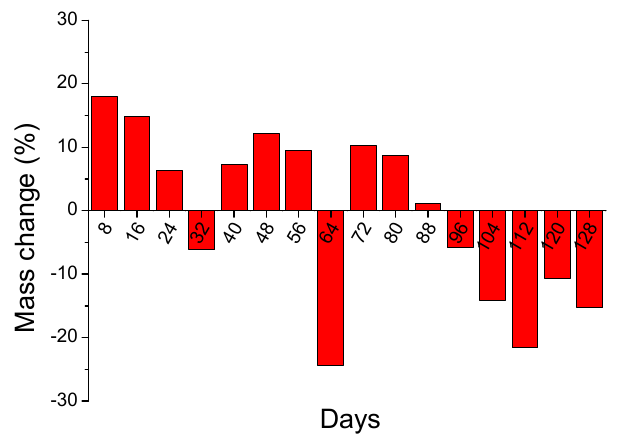
Figure 8. The evolution of mass changes of coated concrete specimens during the application of long-term duration acid spraying test.